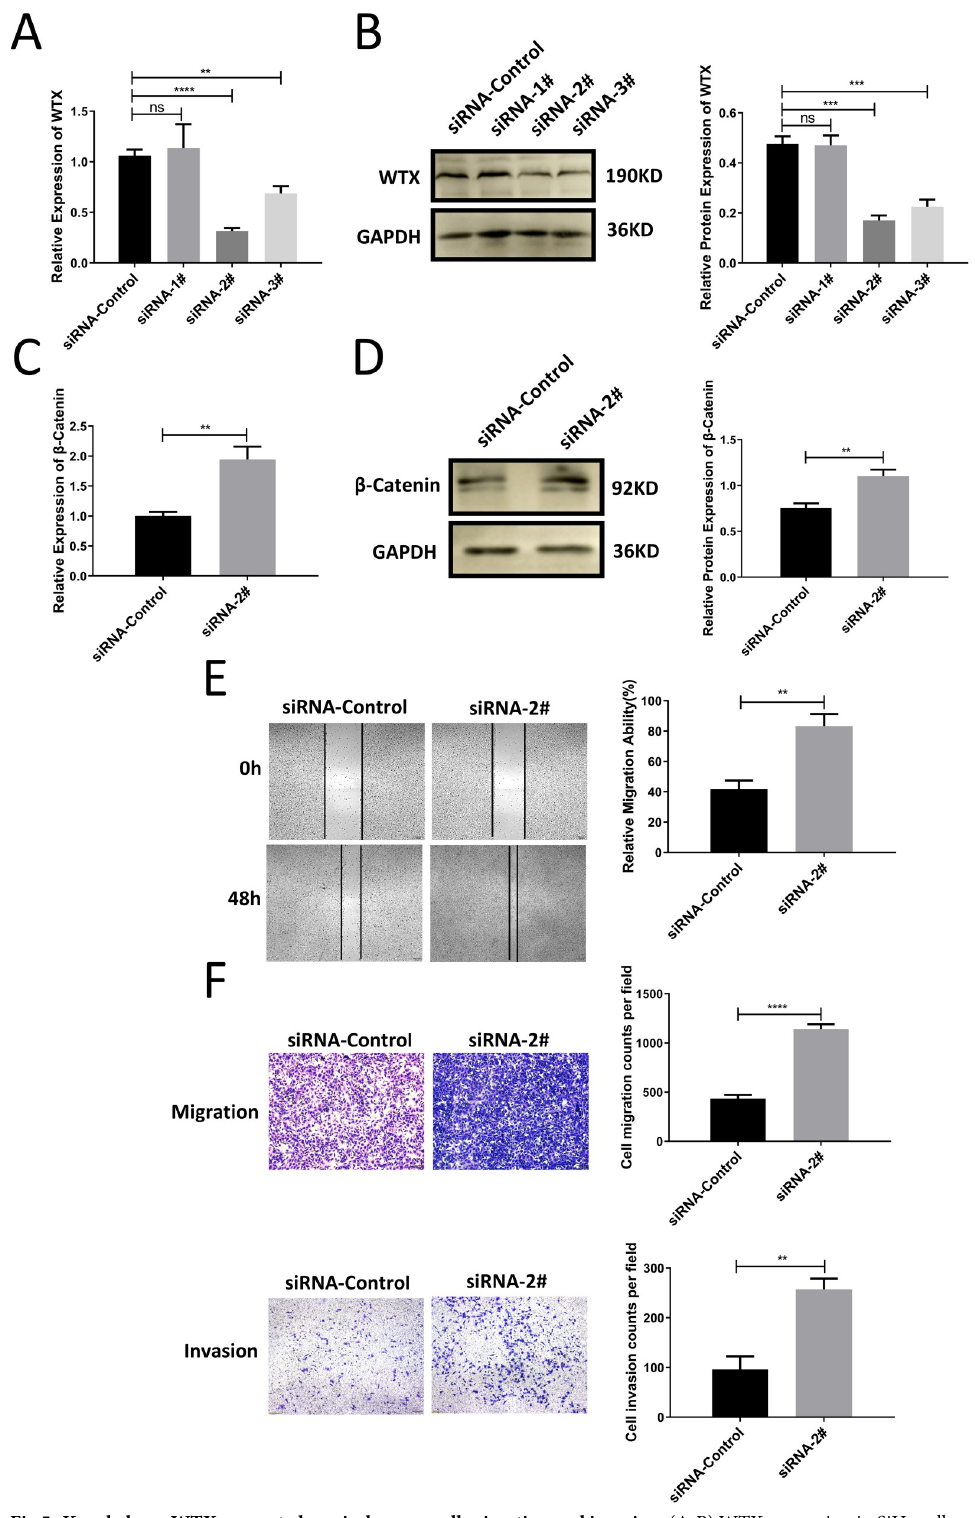
Fig 5. Knock down WTX promoted cervical cancer cell migration and invasion. (A-B) WTX expression in SiHa cells transfected with siWTX-1#, 2#, 3# and siRNA-control. Changes in mRNA abundance were determined by qRT-PCR. Changes in protein abundance were determined by western blotting. (C-D) β -catenin expression in SiHa cells transfected